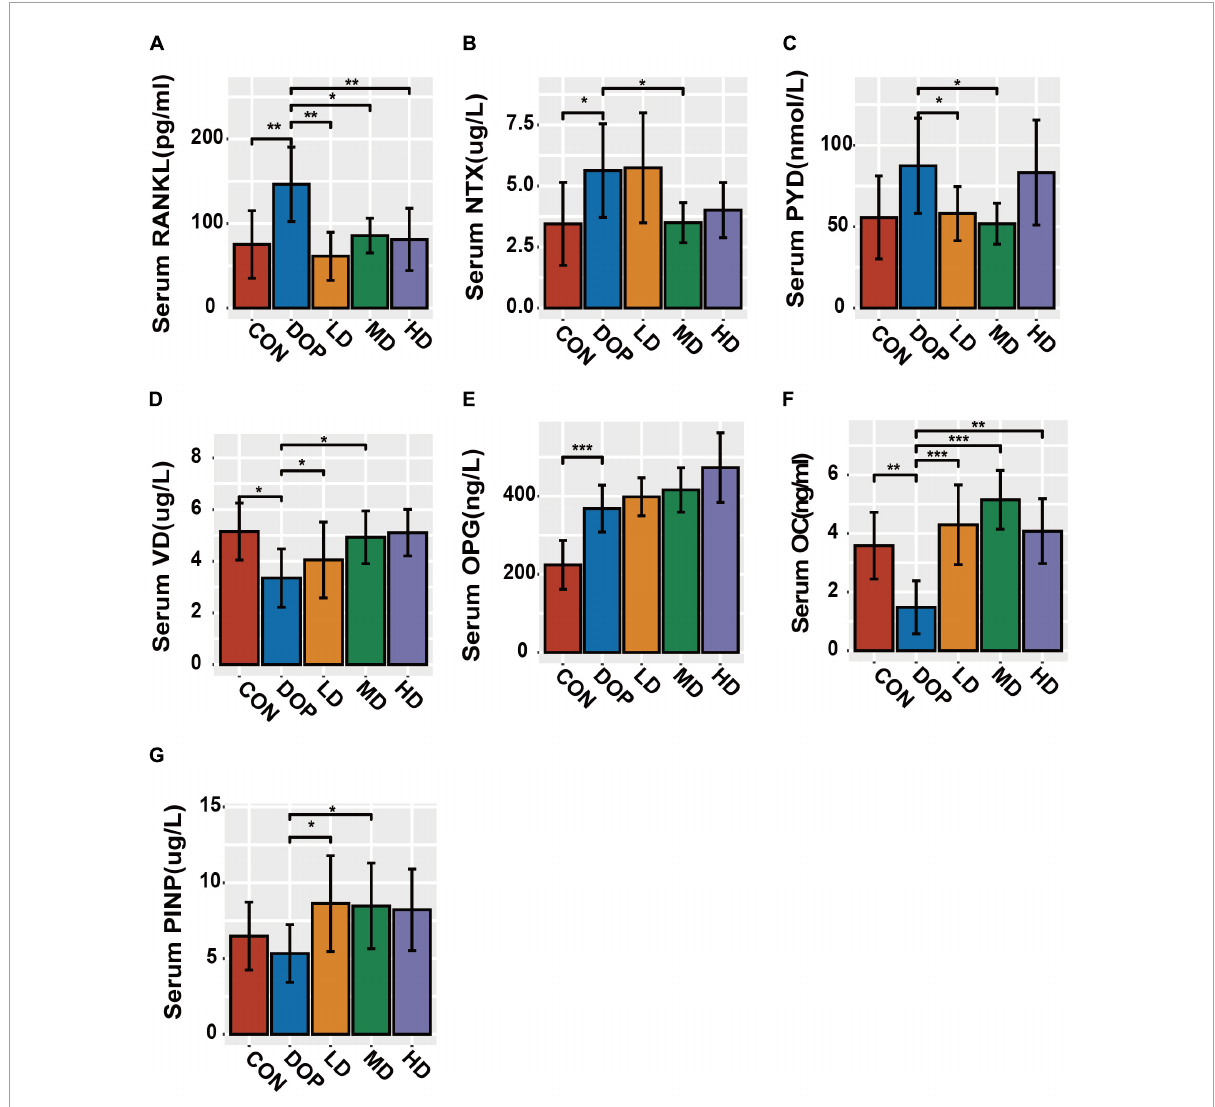
FIGURE5 Bone metabolism in serum biomarker analysis in different groups of rats. (A) Serum RANKL levels; (B) serum NTX levels; (C) serum PYD levels; (D) serum VD levels; (E) serum OPG levels; (F) serum OC levels; (G) serum PINP levels. All data are expressed as the mean ± SD ( n = 5). * p < 0.05, ** p < 0.01, *** p < 0.001 as compared to the diabetic osteoporosis (DOP)